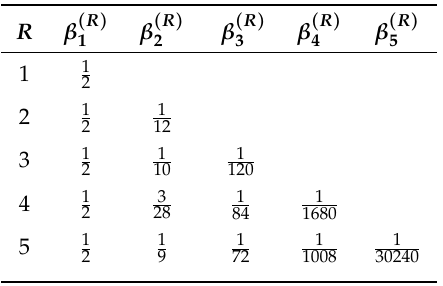
Table 1. Symmetric one-step B-Spline Hermite–Obreshkov (BSHO)